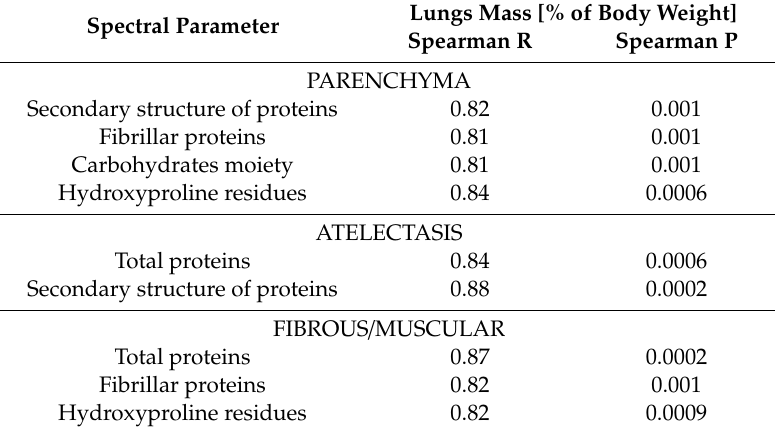
Table 3. The correlation between the lung-to-body weight ratio [%] and selected FTIR biomarkers associated using the Spearman’s rank correlation coe ffi cient (R) and probability